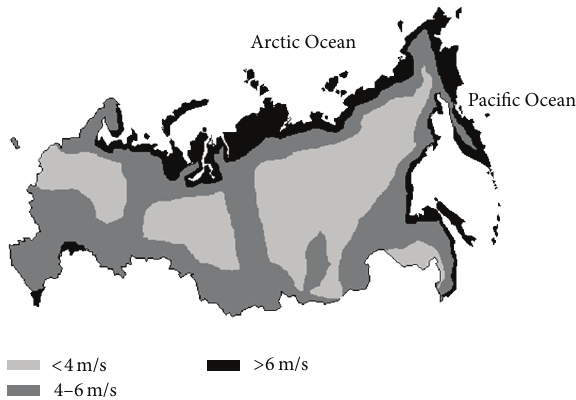
Figure 4: Long-term average annual wind speed 𝑉 (m/s) at a height of 10m on the territory of